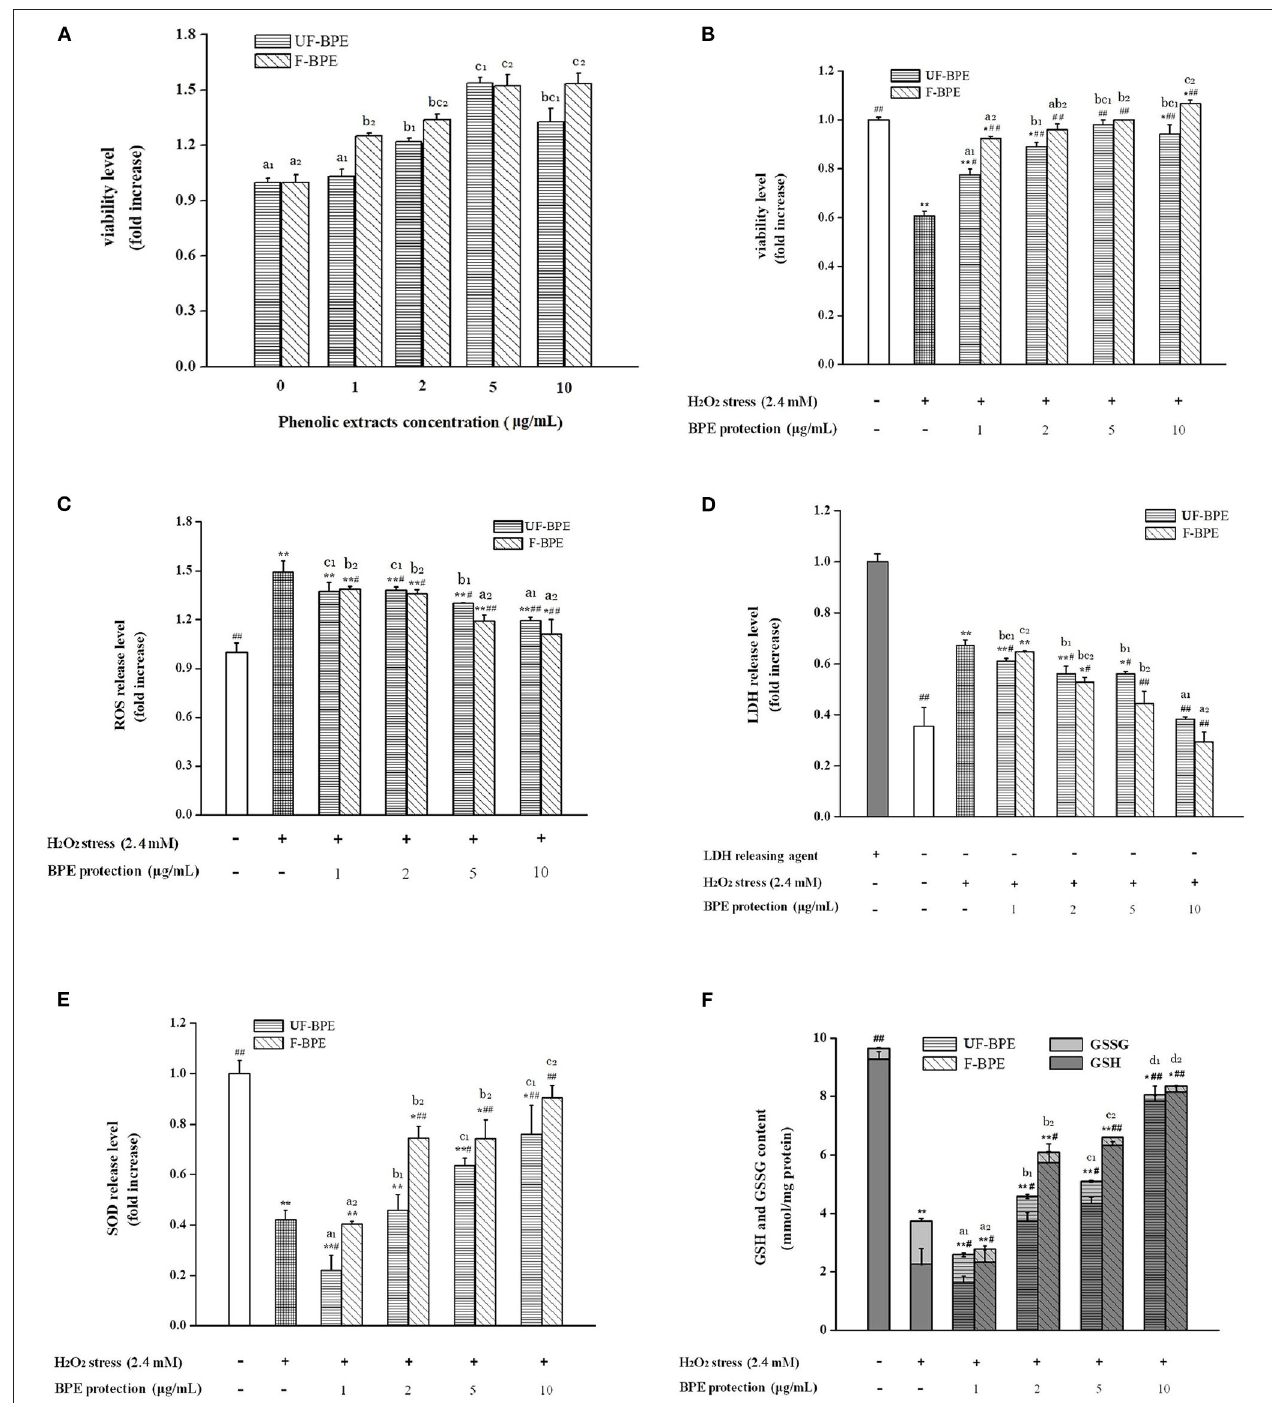
FIGURE 3 | Effects of UF-BPE and F-BPE at different concentrations (1.00–10.0 µ g/mL) on (A) cytotoxicity, (B) cell viability, (C) ROS release level, (D) LDH release level, (E) SOD release level, and (F) GSH and GSSG contents in different HepG2 cell groups. Bars represented mean values ± SD ( n = 5.00). * and ** indicated significant differences at the levels of P < 0.05 and P < 0.01, respectively, between control group and other groups; # and ## indicated significant differences at the levels of P < 0.05 and P < 0.01, respectively, between oxidative model group and other groups. Mean values of the same extract with different lowercase letters were significantly different at the level of P <